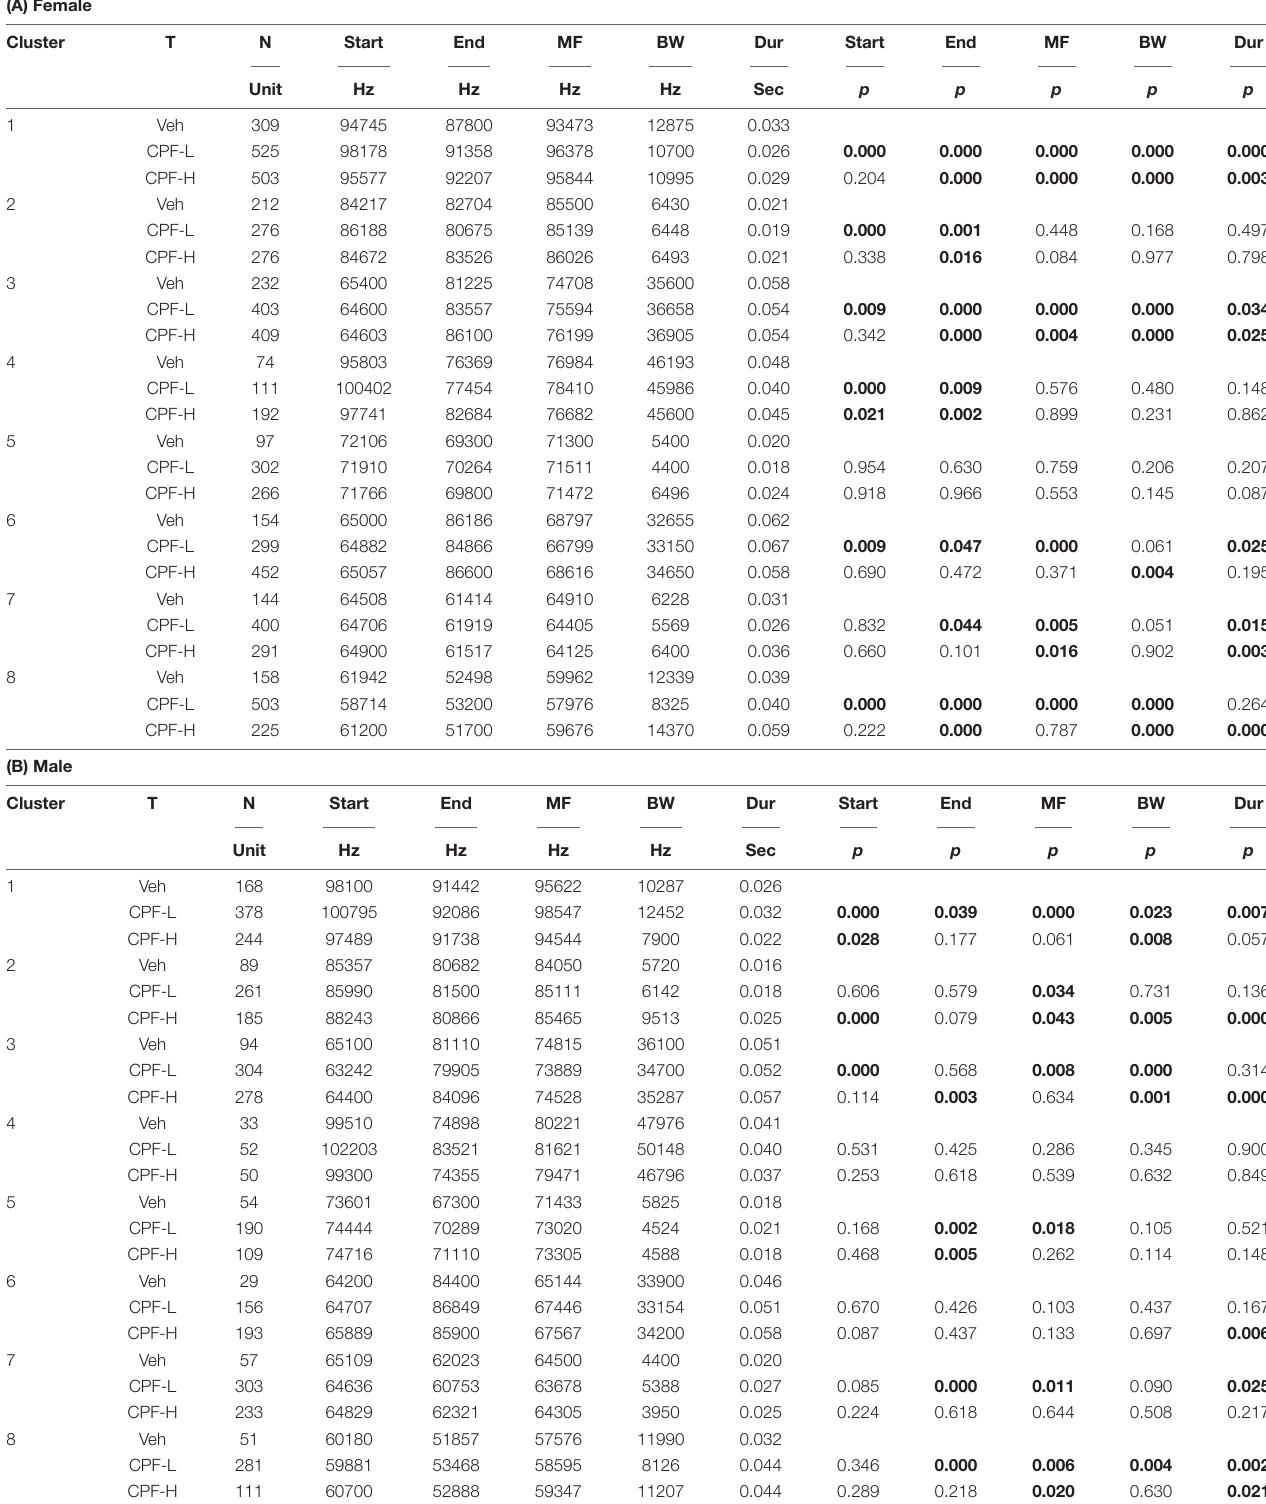
Median values for the CPF mice: A, female; B. male. The five columns on the right show the p values of the Kolmogorov-Smirnov test for the effect CPF. Bold values indicate a significant effect compared to the vehicle group. CPF-L, CPF low dose; CPF-H, CPF high dose; MF, mean frequency; BW, bandwidth; Dur, duration; T, treatment; N, number of